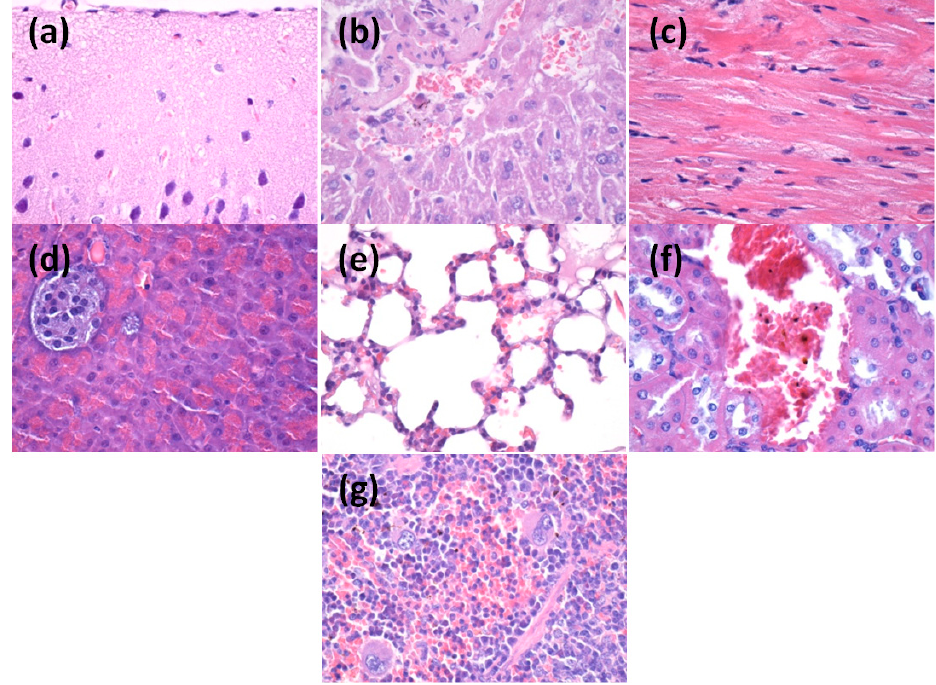
Figure 10. Transversal section through: ( a ) brain; ( b ) liver; ( c ) myocardium; ( d ) pancreas; ( e ) lungs; ( f ) kidneys; and ( g ) spleen from mice injected with AgNPs; samples collected at two days after the treatment; Hematoxylin-Eosin coloring (400× magnification, Nikon Instruments, Bucharest, Romania).